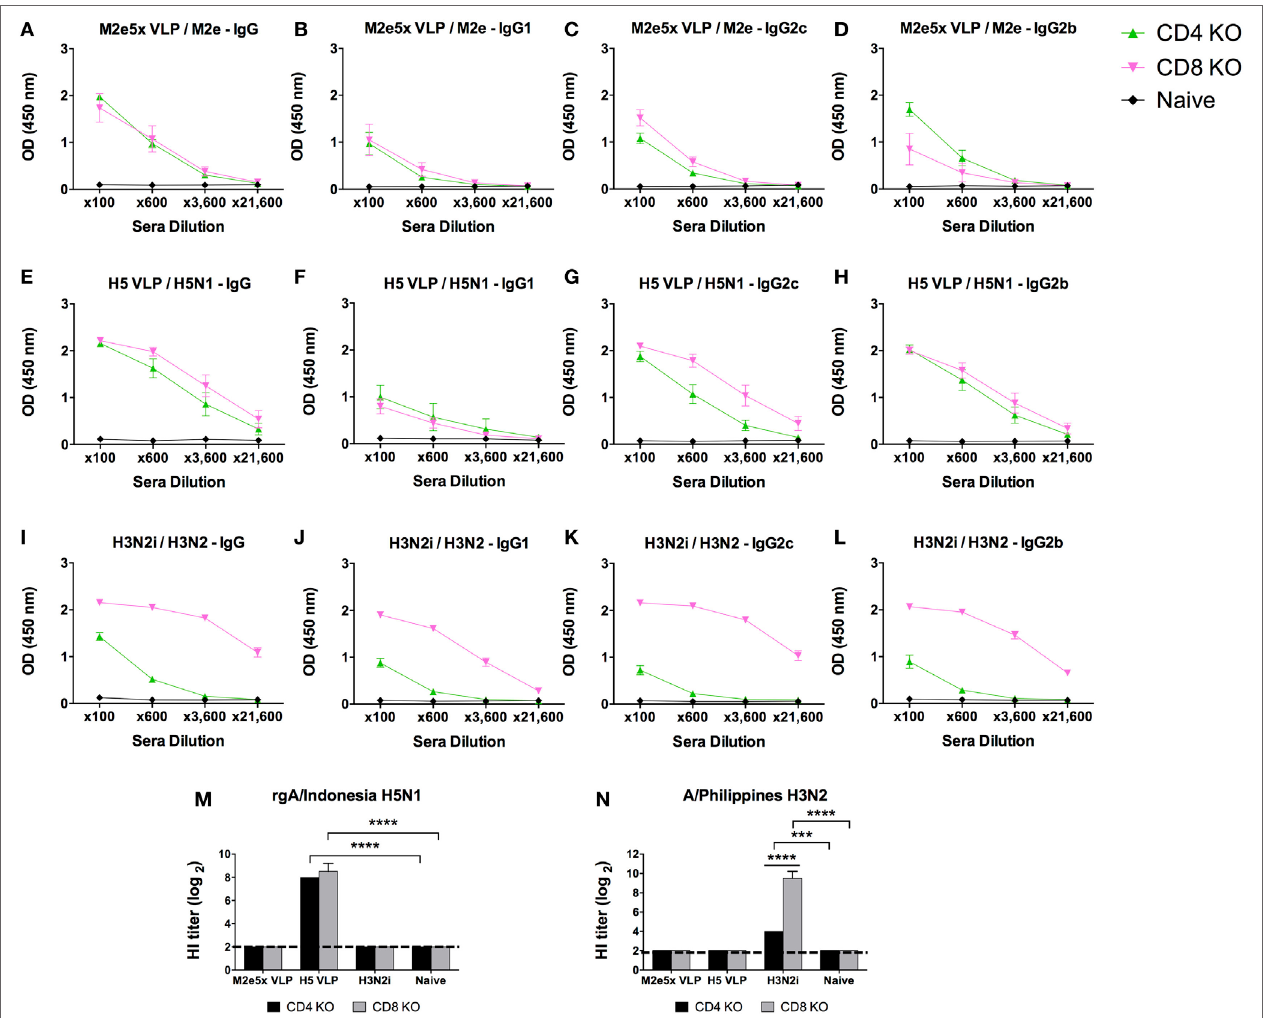
FigUre 5 | IgG isotype antibody responses in CD4 knockout (CD4 KO) and CD8 knockout (CD8 KO) mice after vaccination with different influenza vaccines. Each group of CD4 KO and CD8 KO mice ( n = 10) was prime and boost intramuscularly immunized with 10 µg of M2e5x virus-like particle (VLP) (a–D) , H5 VLP (e–h) , or H3N2i (i–l) . Antibody levels of IgG (a,e,i) , IgG1 (B,F,J) , IgG2c (c,g,K) , and IgG2b (D,h,l) were detected by enzyme-linked immunosorbent assay (ELISA). The same influenza antigens were used for ELISA as described in Figure 2 . Error bars indicates mean ± SEM. (M,n) Hemagglutination inhibition (HI) titers. HI titers against rgH5N1 (M) and H3N2 (n) were determined from immune sera of M2e5x VLP, H5 VLP, or H3N2i. Statistical significances as determined by 2-way ANOVA: *** p < 0.001, **** p <